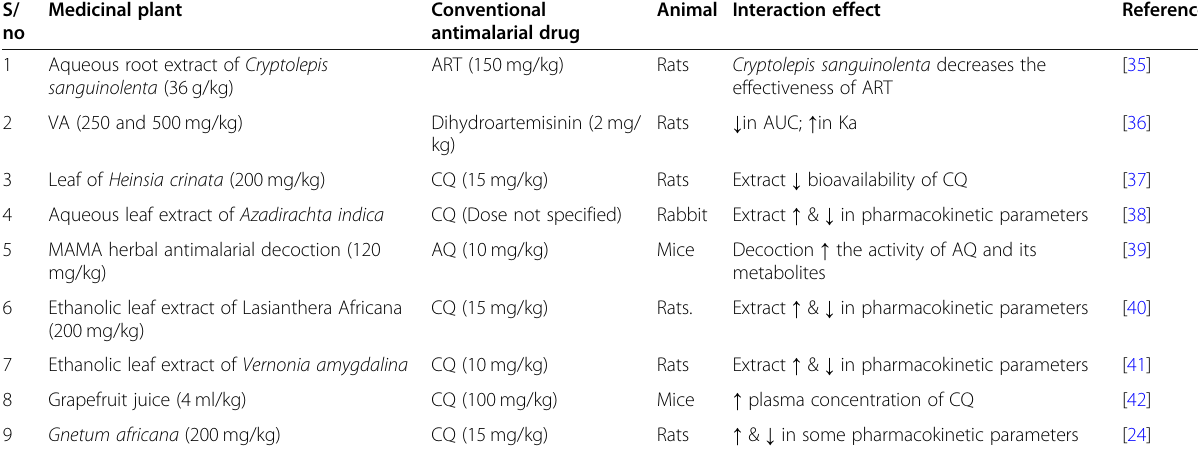
Table 3 Summary of studies on herbal-antimalarial drug interactions in normal animals (mice, rats and rabbits) S/ Medicinal no